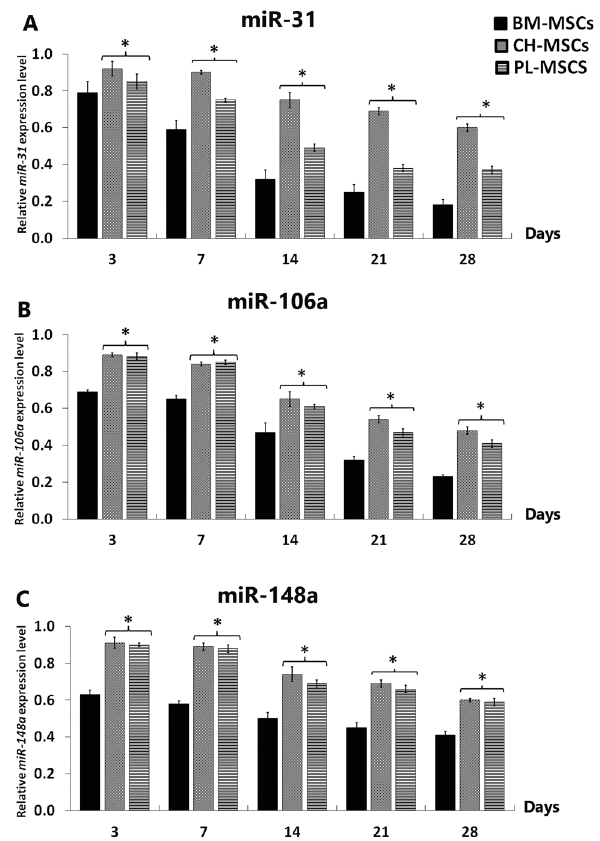
Figure 6. The expression of miR-31, miR-106a, and miR-148a of CH-MSCs and PL-MSCs compared to BM-MSCs. Data were calculated based on averages of 3 samples per each condition. * p <0.05 compared to BM-MSCs.